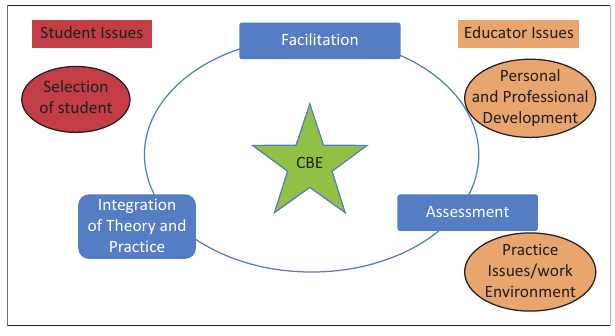
FIGURE 2: Synthesis of